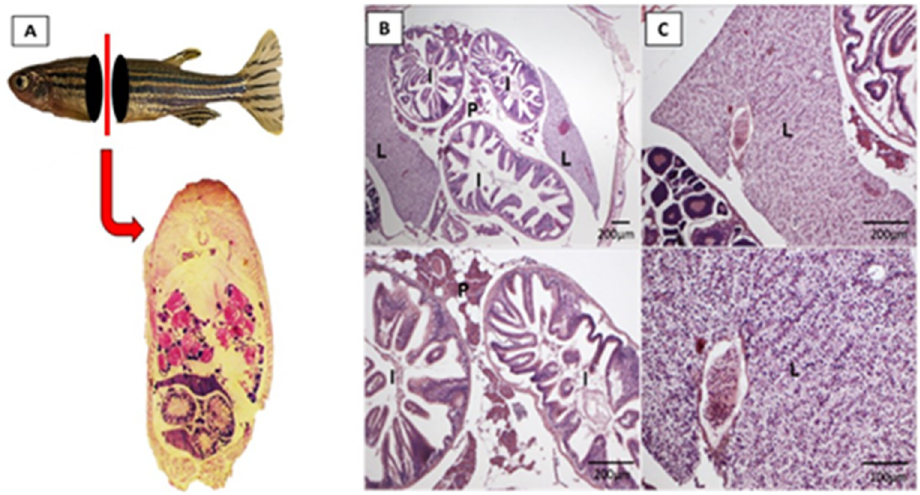
Fig 7. Histopathological analysis of fish exposed to NPMAs: Adult zebrafish exposure to NPMAs at concentrations of 25 and 50 mg/L -1 . (A), (B) and (C) show fish sections without relevant pathological alterations. (L) liver; (P) pancreas and (I) intestine (H&E